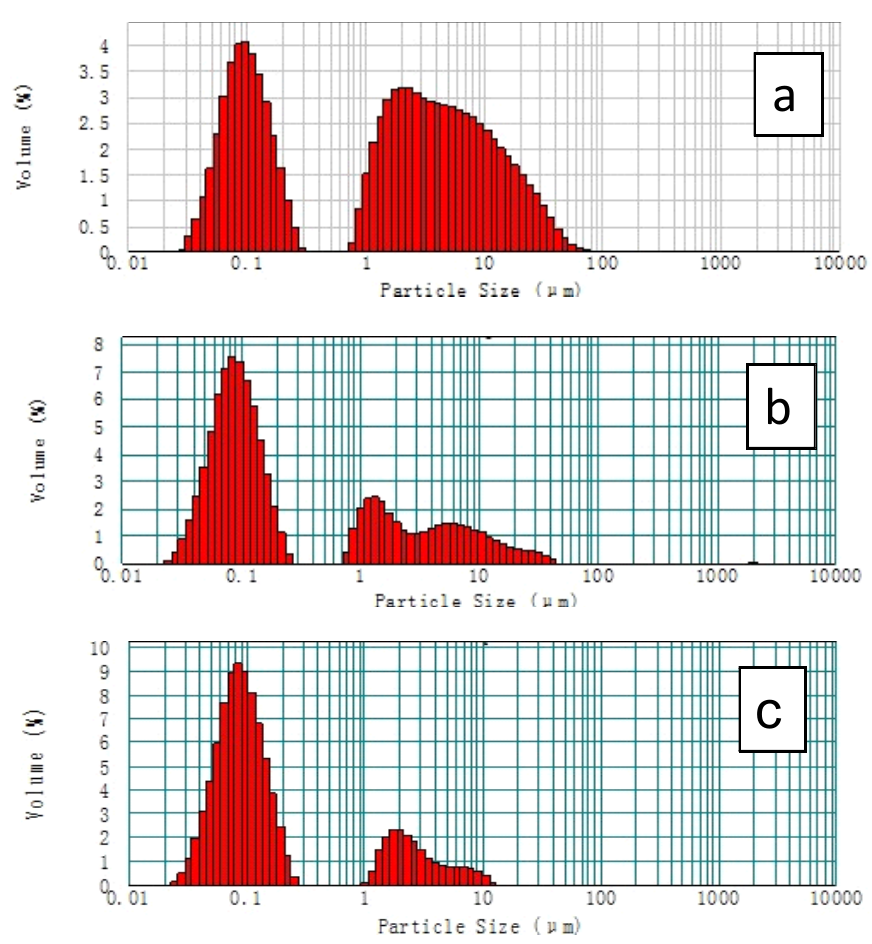
Figure 2. Particle size distributions of catalyst inks pre-heated at ( a ) 25 °C; ( b ) 50 °C and ( c ) 80 °C.